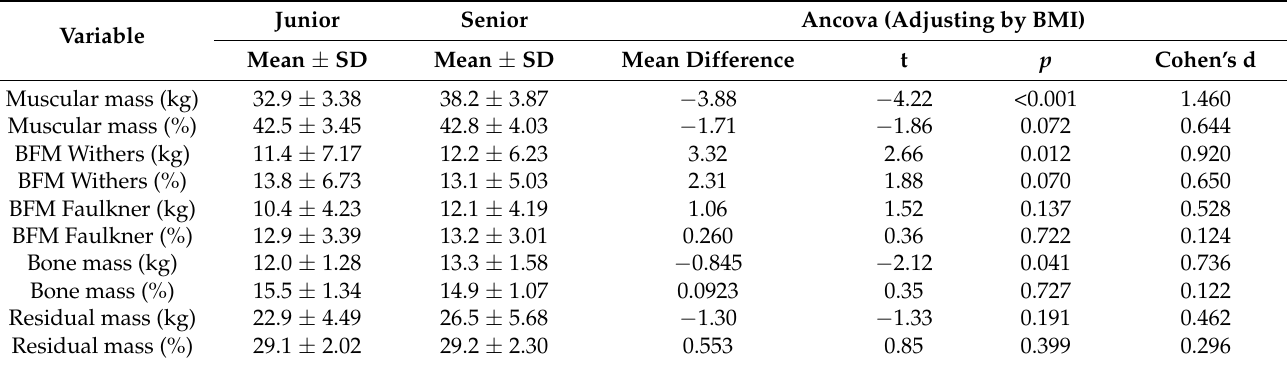
Table 2. Descriptive data on body composition and differences between senior and